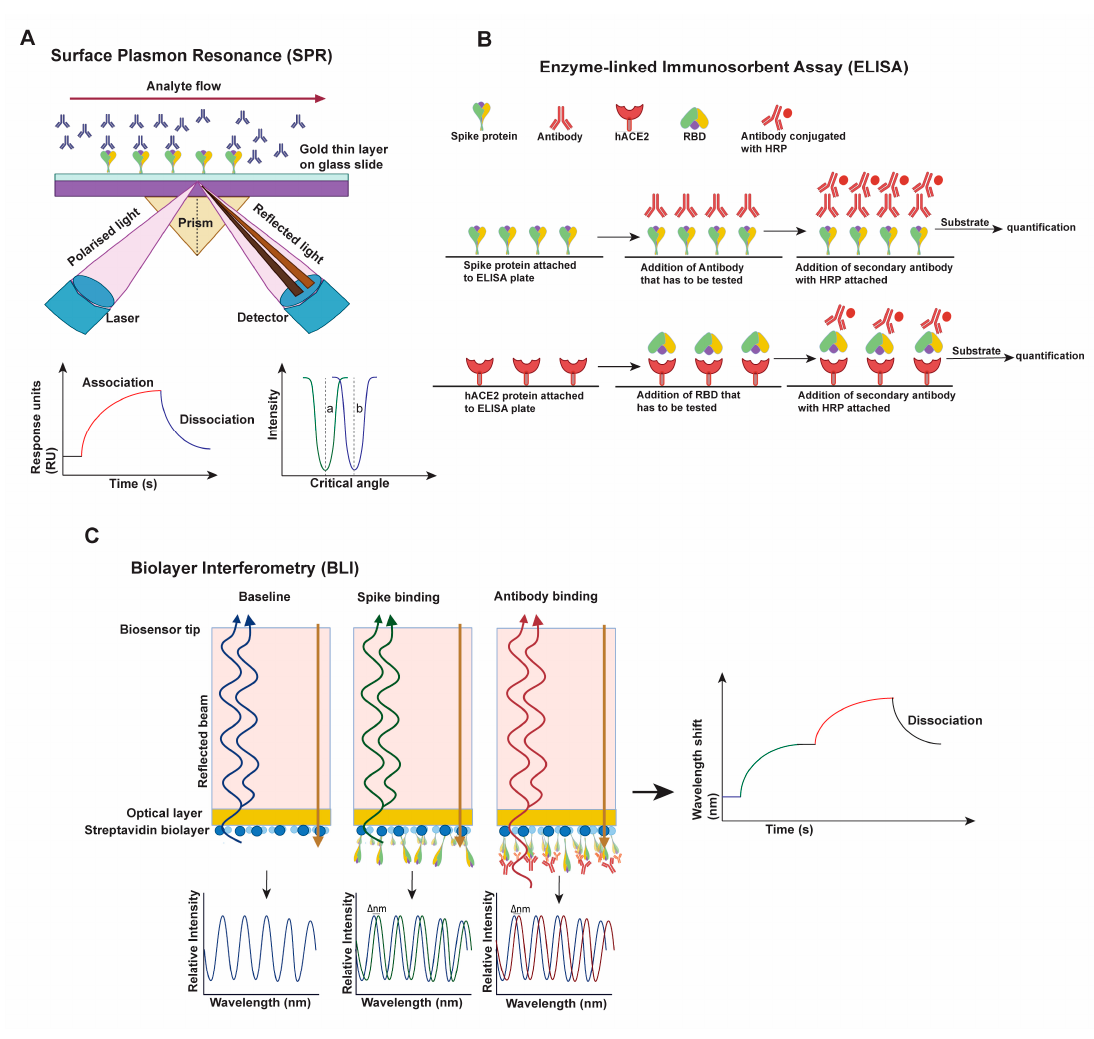
Figure 2. Schematics depicting the ligand-binding techniques used to characterize the binding of S to antibodies or hACE2. ( A ) Surface plasmon resonance (SPR) technique. SPR is an optical technique that can be used to analyze the binding of S protein with antibodies or hACE2. One of the interacting molecules is immobilized in the gold-layer sensor chip, and another interacting partner is flown through the microfluidic system. The interaction between the two molecules causes the change in the refractive index of the light, which is recorded as the response signal and measured in the response unit (RU). The plot generated by monitoring RU over time yields the binding kinetics for two interacting molecules. ( B ) Enzyme-linked immunosorbent assay (ELISA). ELISA, which is based on the antigen-antibody interaction, effectively profiles the binding of S or its fragment (such as RBD) to an antibody or hACE2. The quantification of binding is evaluated based on the HRP chemiluminescence (conjugated to secondary antibody) or the conjugated fluorescent protein. ( C ) Bio- layer interferometry (BLI) analysis. BLI is an optical technique for exploring the interaction between S and an antibody or hACE2. One of the interacting molecules is immobilized in the streptavidin layer attached to the biosensor, and another interacting molecule remains in the solution. Binding events of each molecule in the biosensor result in the change in the interference pattern when white light is passed through it. The plot of this change over time yields the binding kinetics of two